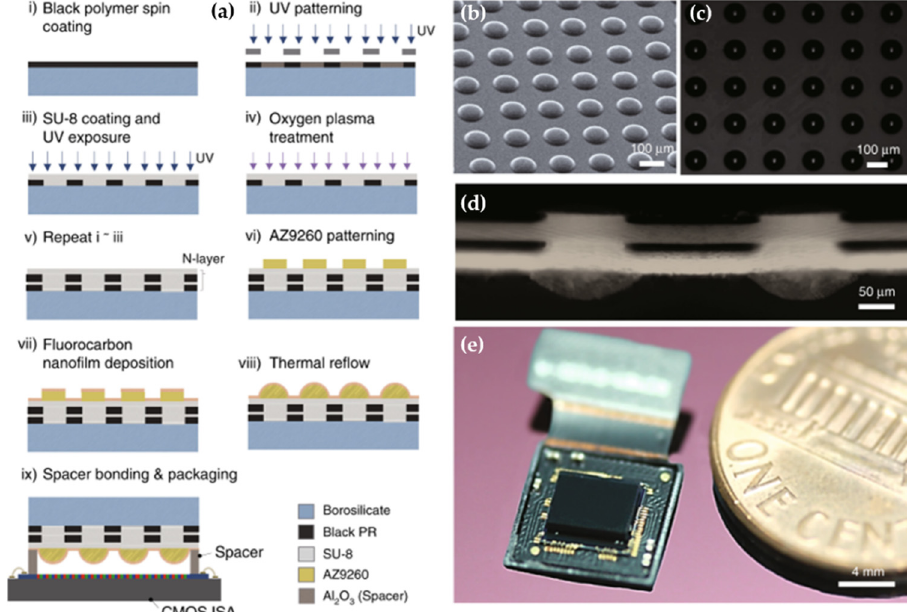
Figure 9. ( a ) The micro fabrication method of the micro-optical elements. ( b ) The scanning electron microscopy of MLAs. ( c ) The optical microscopy images of MLAs. ( d ) The cross-sectional optical image of the Micro Optical Element. ( e ) The structure of a fully packaged ultrathin arrayed camera. Reproduced from [40]. CC by 4.0. Table 2. The parameters and performance of the planar-type artificial compound eye system.